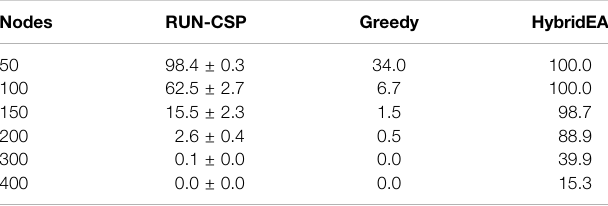
TABLE6| M AX -3-C OL :Percentagesofunsatis fi edconstraintsforeachgraphclass underthedifferentRUN-CSPmodels.Values areaveragedover1,000graphs andthestandarddeviationiscomputedwithrespecttothe fi veRUN-CSPmodels. Graphs M ER ( % ) M Geo ( % )